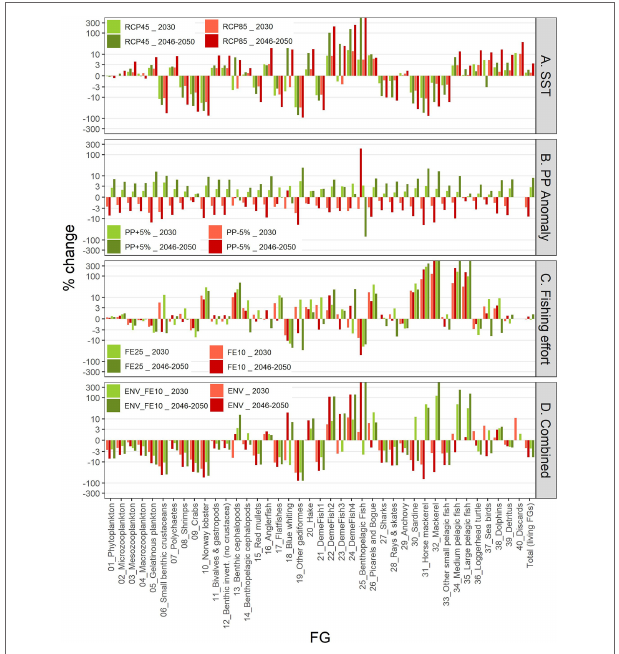
FIGURE 8 | Graphical representation of differences (%) in biomasses in 2030 and average biomasses in the period 2046-2050 for each FG under each scenario compared to the baseline scenario. Y-axis scale is pseudo- logarithmic for better representation. The description of the scenarios is provided in Table 2